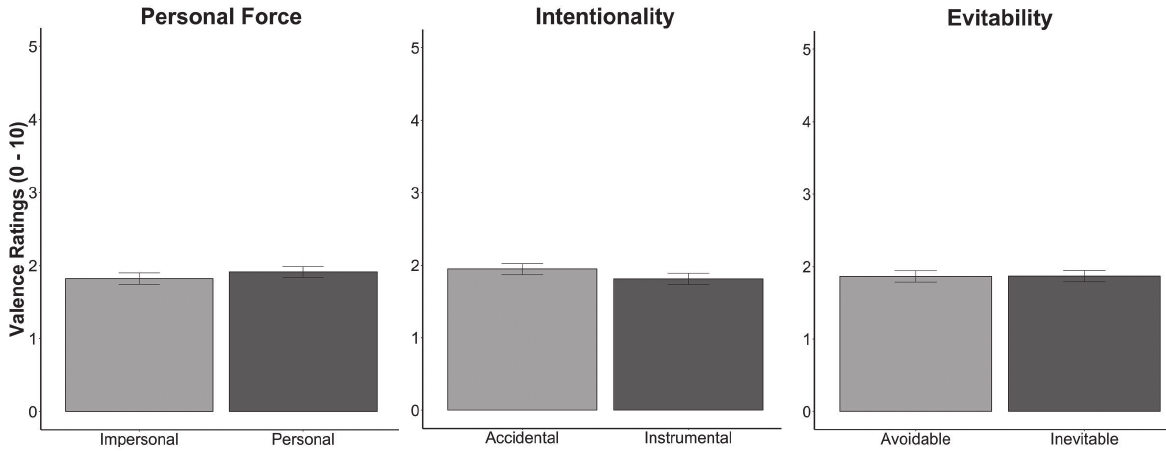
Figure 2. Valence ratings distribution per conceptual factors. Error bars represent CI of LMM model. Significant differences ( P < 0.05) are indicated via